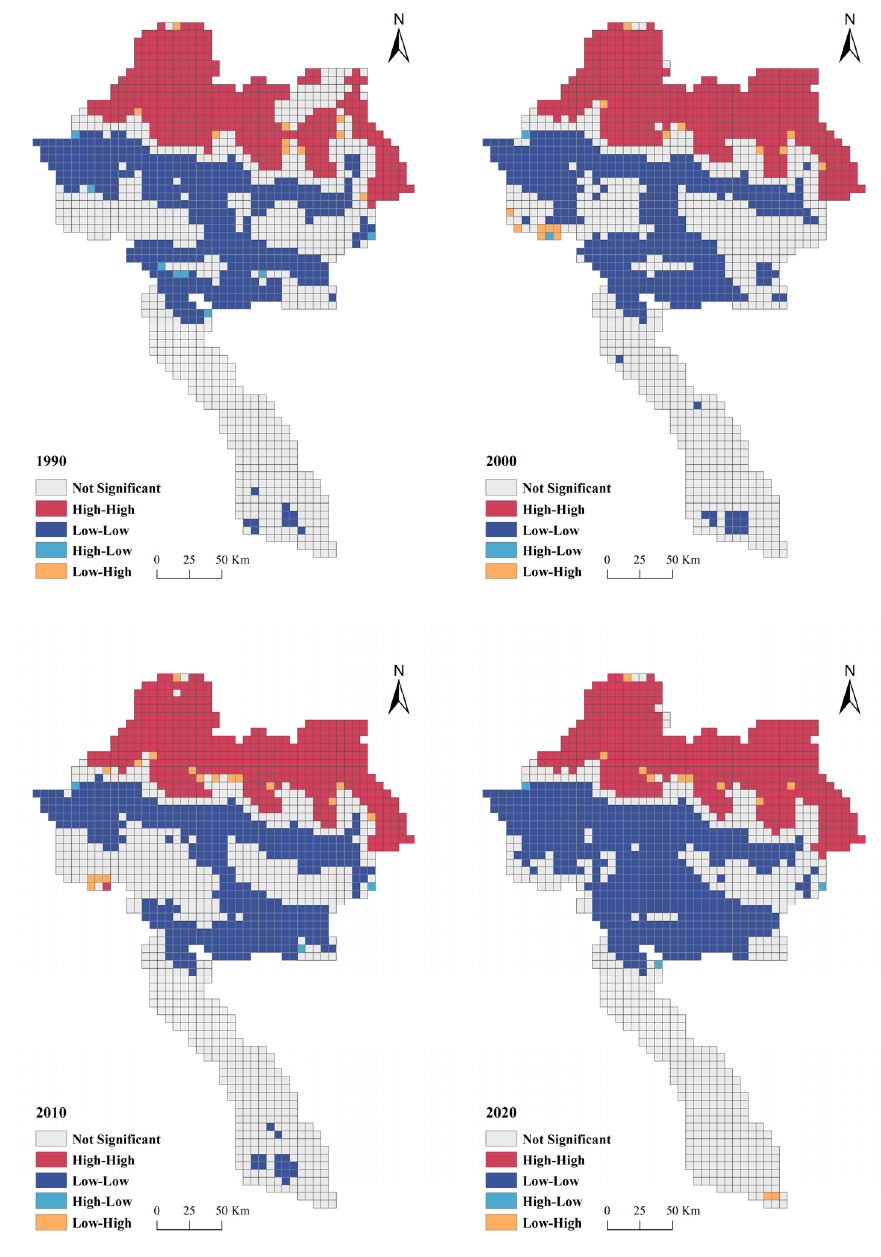
Figure 6. Local spatial autocorrelation analysis of ecological risk in Gandaki river Basin.